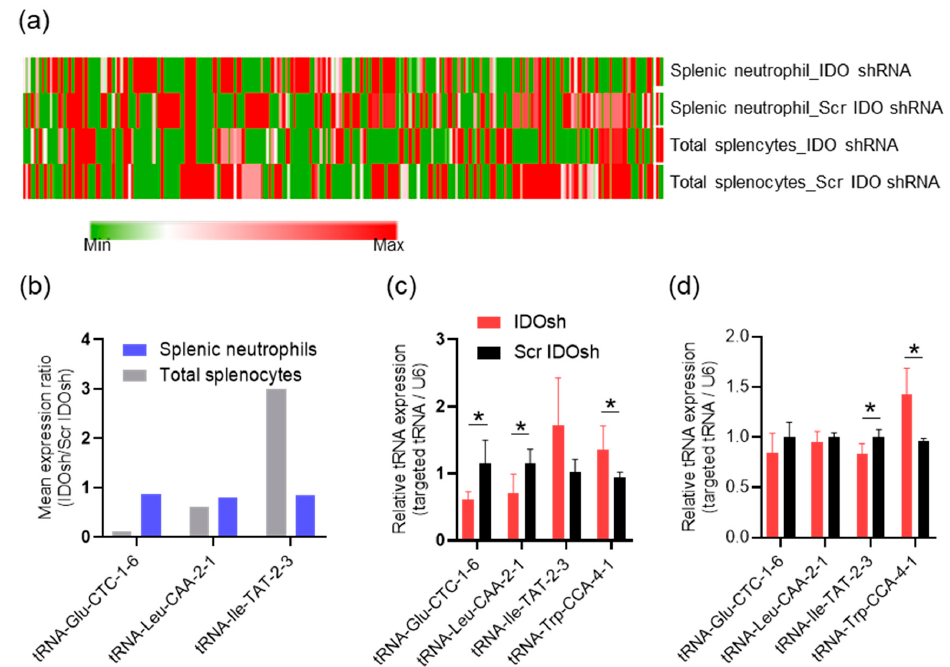
Figure 4. The expression of tRNA genes. ( a ) The heatmap shows the expression of each tRNA gene. Each column indicates a specific tRNA gene. The relative color scheme is based on minimum-maximum values (RPKM), per column. ( b ) The expression of some tRNA genes identified via RNA sequencing in total splenocytes and splenic neutrophils. ( c ) The expression of some tRNA genes identified via QPCR in total splenocytes, and ( d ) in splenic neutrophils. n = 3–4 in QPCR analysis. * A statistically significant di ff erence when compared with the Scr IDO shRNA group (* p <